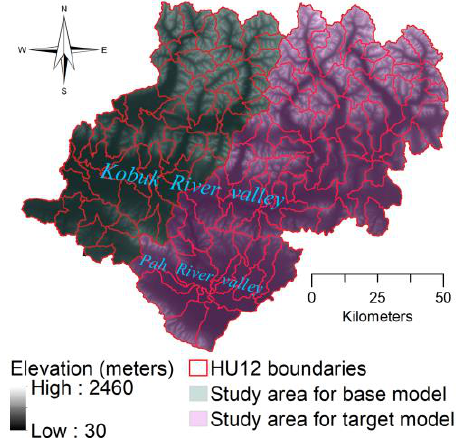
Figure 2. Elevation and 12-digit hydrologic unit (HU12) boundaries for base and target model